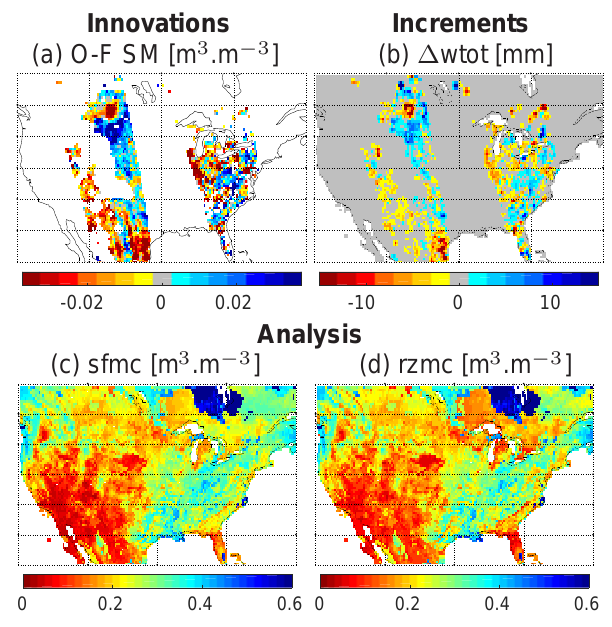
Figure 3. Soil moisture analysis on 30 April 2015 at 12:00 UTC for the SM retrieval assimilation system. (a) SM innovations (O– F); (b) increments in total profile water ( (cid:49) wtot); ( c , d ) assimilation analyses of surface soil moisture (sfmc) and root-zone soil moisture